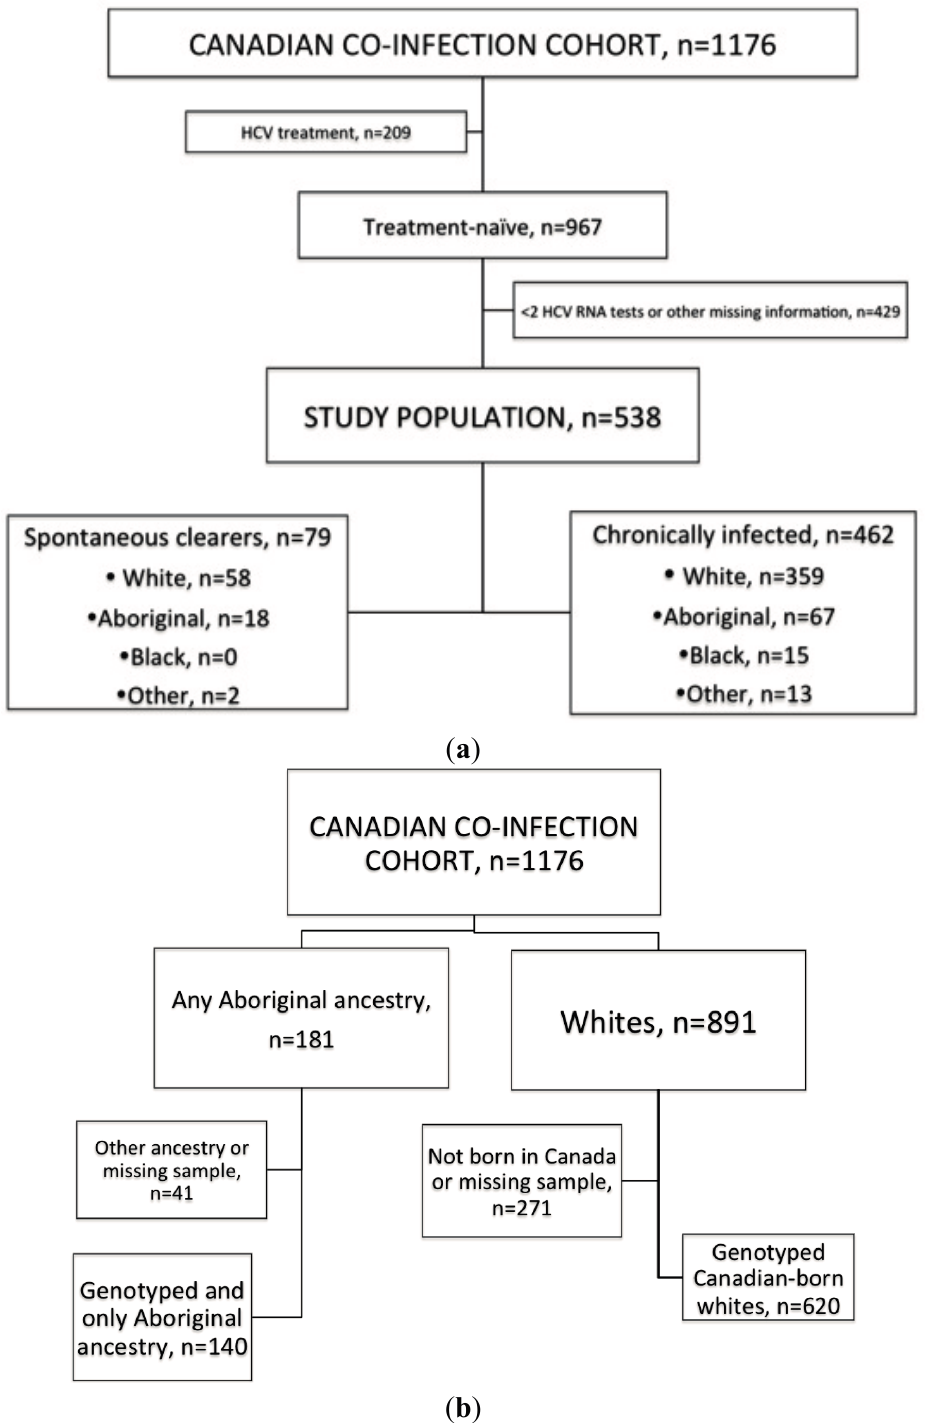
Figure 3. Study and source population: ( a ) Selection of study population for evaluating the association of IFNL3 genotypes and rates of spontaneous clearance; ( b ) Selection of study population for comparison of IFNL3 frequency distribution between Canadian Aborginals and